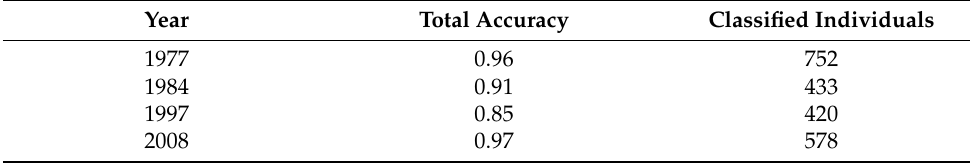
Table 7. Accuracy of image classifications.